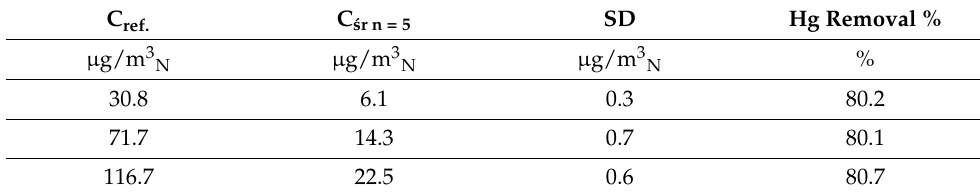
Table 6. Influence of Hg concentration on mercury removal by